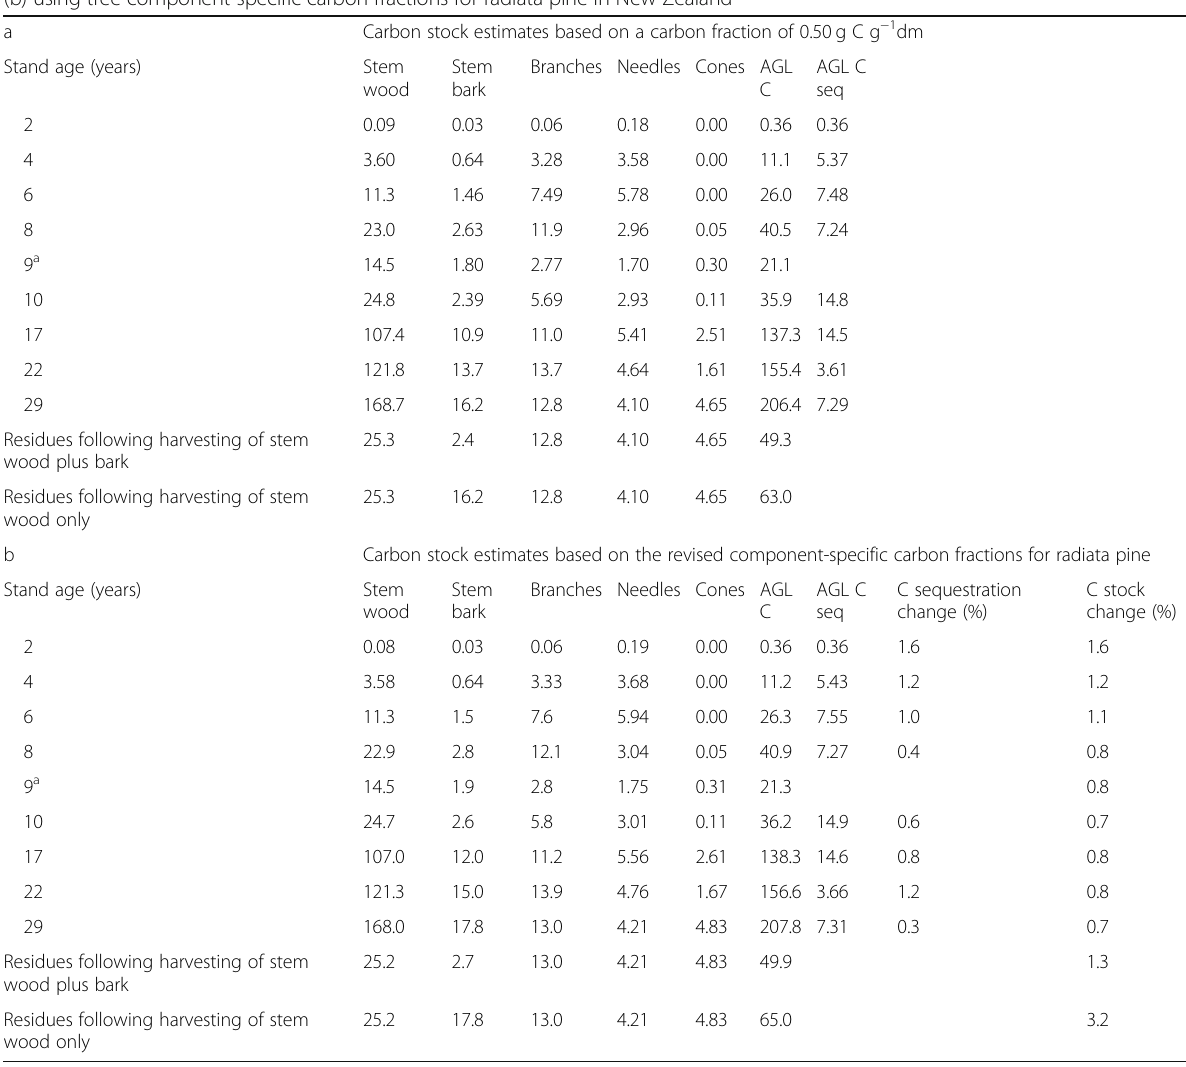
Table 6 Carbon stock (t/ha) and sequestration (t/ha/year) estimates calculated by applying carbon fractions to radiata pine stand dry matter estimates in Madwick et al. (1977) and Webber and Madgwick (1983): (a) using a default carbon fraction of 0.50 g C g − 1 dm and (b) using tree component-specific carbon fractions for radiata pine in New Zealand